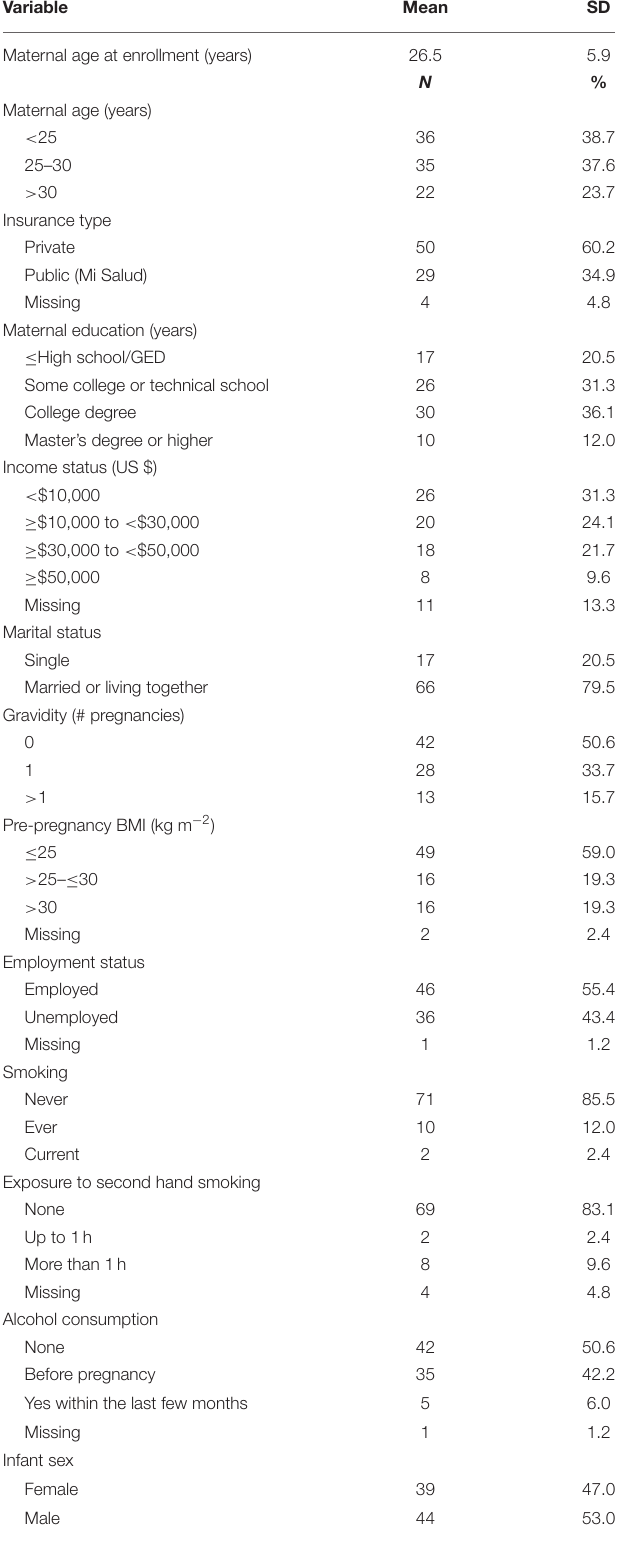
TABLE 1 | Demographic characteristics of n = 83 pregnant women from Puerto Rico with maternal metals/metalloid blood levels and lipidomics data available.